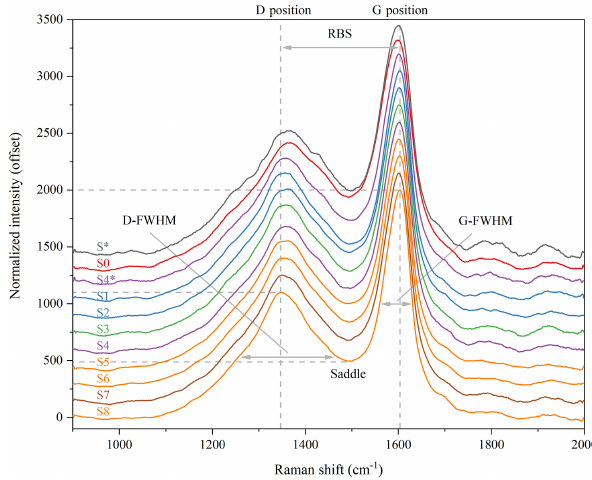
Figure 10. The processed Raman spectra of coal samples, showing the spectra differences between unsheared samples (S ∗ and S0) and sheared samples (S1–S8). Note that different colors mean different experimental conditions, and S4 ∗ represents the weakly deformed zone of sample S4. Some important parameters were marked ac- cording to Henry et al.